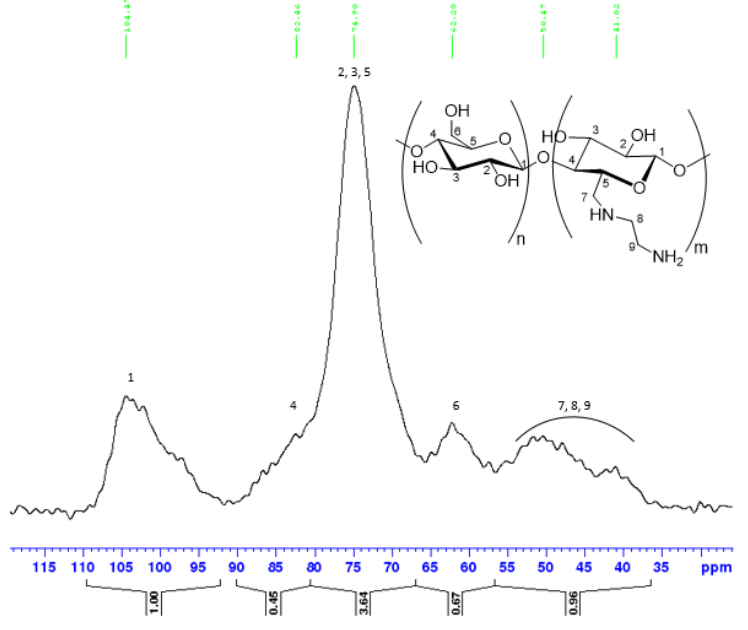
Figure 3. Quantitative 13 C-NMR spectrum of CEDA.